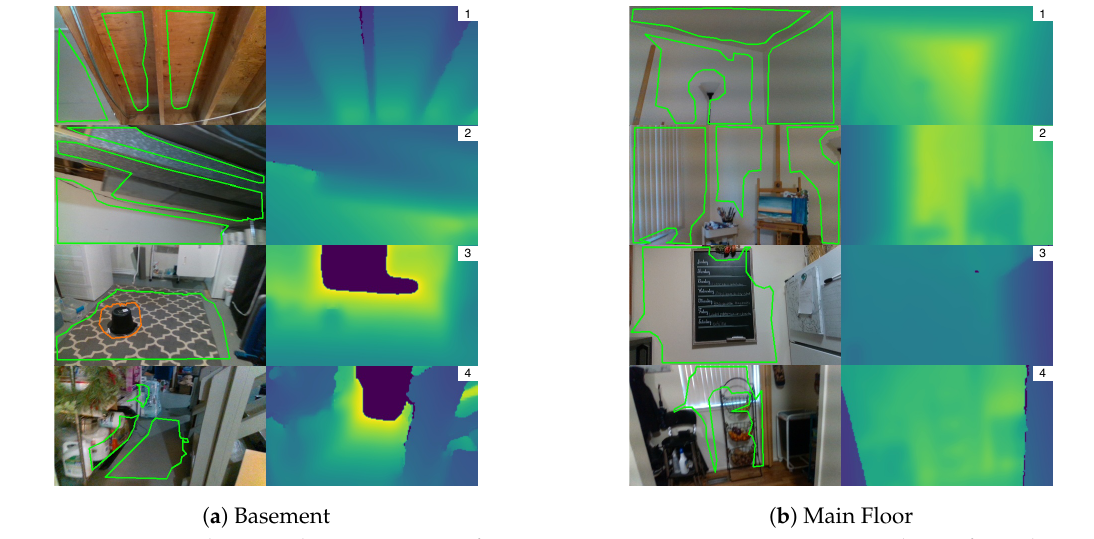
Figure 18. Real-time polygon extraction from an RGBD camera. Four scenes are shown from the basement ( a ) and main floor ( b ) datasets. Color and depth frames are shown side by side for each scene. Polygons are projected onto the color image. Green denotes the exterior hull, and orange denotes any interior holes in the